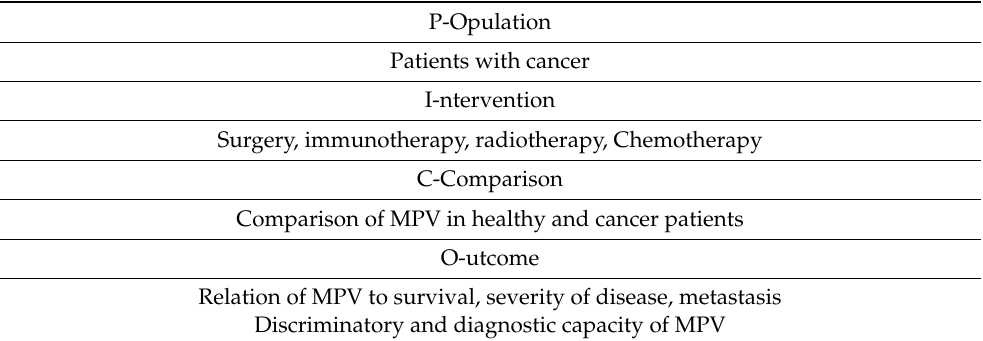
Table 1. Formulation of the research question (Population, Intervention, Comparison,